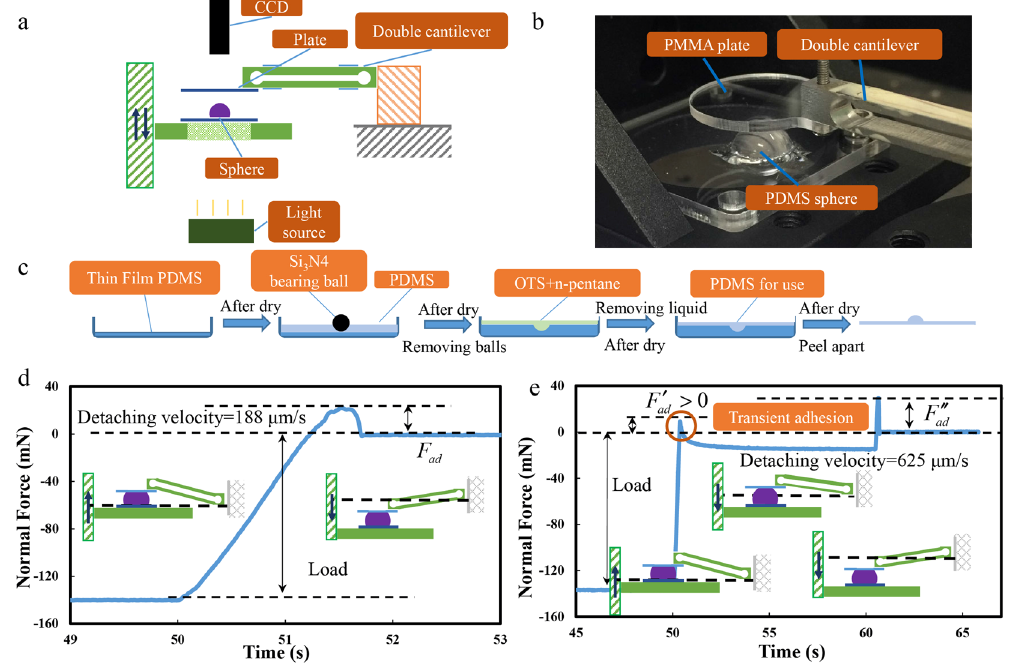
Figure 1. Sketch of the adhesion test system and typical test curves. ( a ) Diagram of the test system; ( b ) Oblique view of the sphere/plate contact; ( c ) Manufacturing procedure of the PDMS sphere; ( d ) Typical force curve of an one-step detachment (a loading displacement L 0 and detaching displacement L ′ 0 > L 0 ); ( e ) Typical force curve of a two-step detachment showing an transient adhesion, the first detaching L 1 and the second detaching L 2